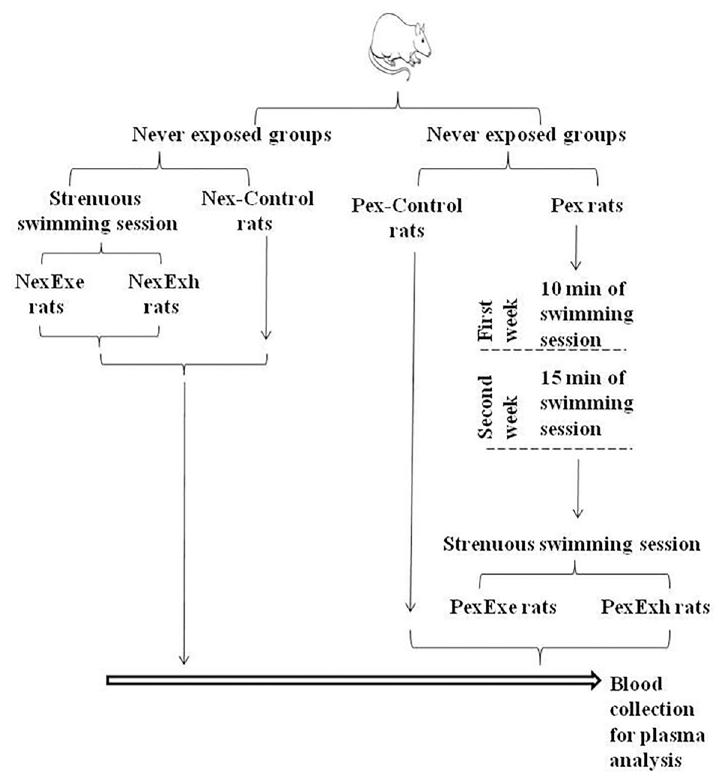
Figure 1. Experimental design. Left side: Never exposed (Nex) protocol. Two Nex rats were placed in the water tank, and once the fi rst rat reached exhaustion (NexExh), the second rat was immediately removed from the water (NexExe). The control group (Nex-Control) consisted of rats placed in the water tank and immediately removed. Right side: Pre-exposed (Pex) protocol. In the fi rst week, rats were submitted to 10-min daily exercise and in the second week, they swam for 15 min each day. On the last day, a pair of rats were left in the water for 15 min to swim (PexExe) or until exhaustion (PexExh). Control rats (Pex-Control) were placed in the water tank and immediately